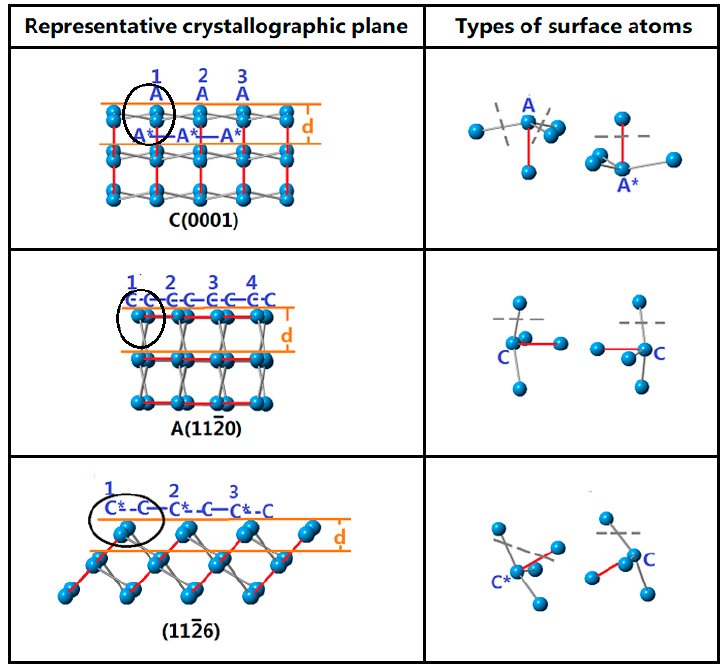
Figure 8. Atomic structures and types of surface atoms of representative crystal planes in Part A.